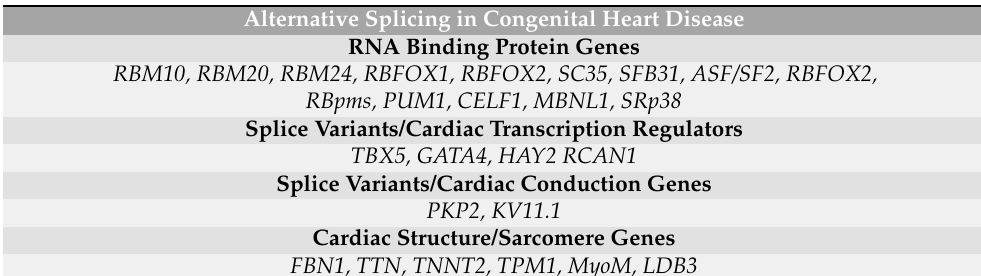
Table 2. Summary of Topics Highlighted in the Review. TOP cardiac-enriched genes encoding RNA binding proteins and other cardiac genes that are affected by alternative splicing or splicing variants are listed based on their functional